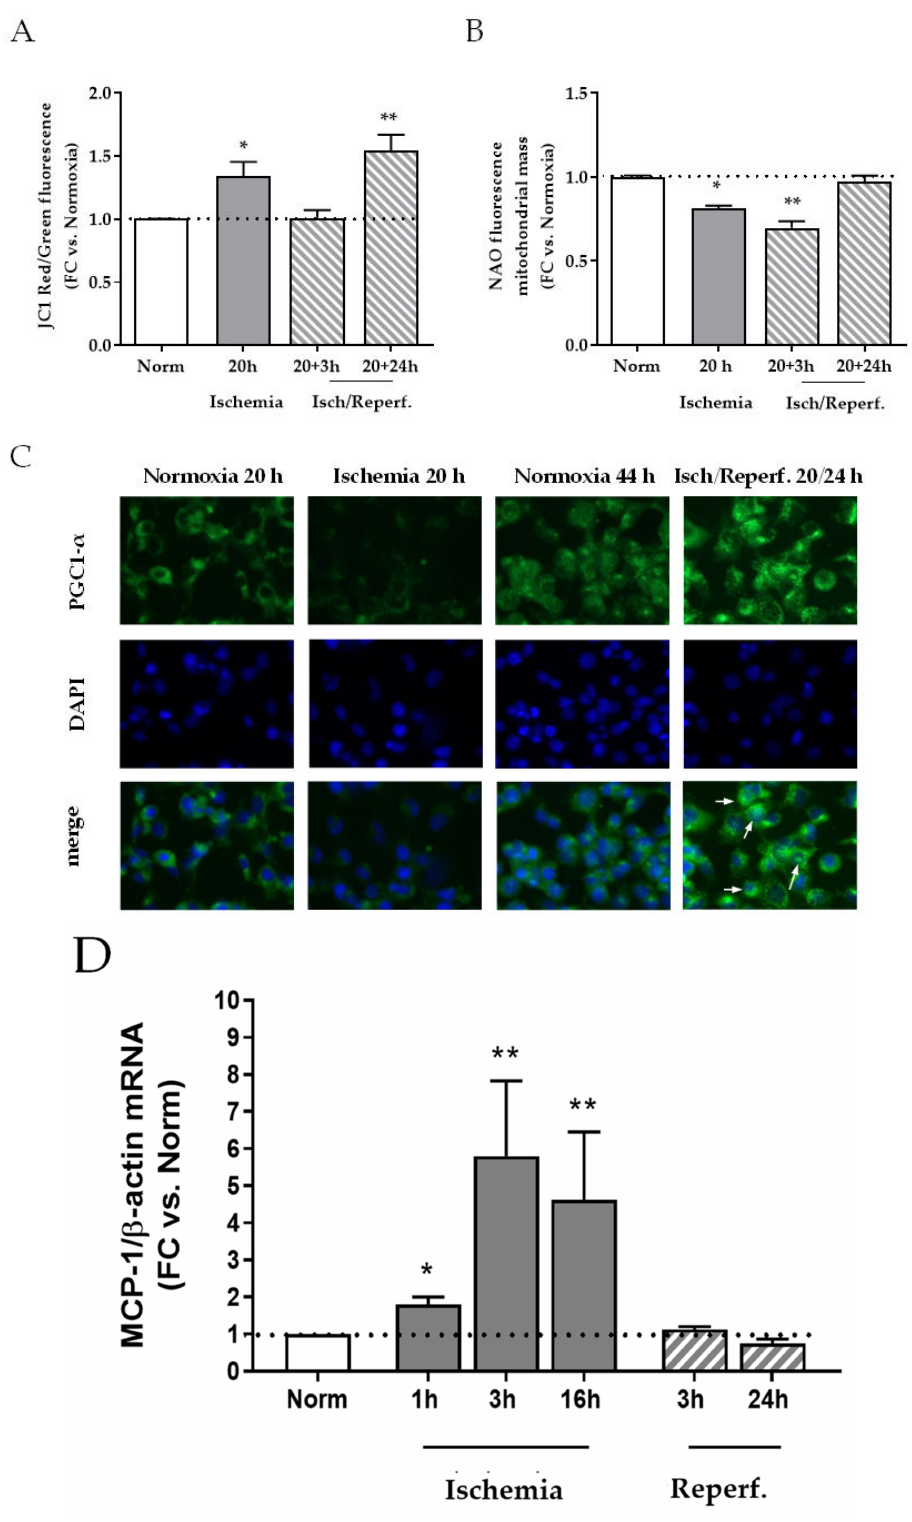
Figure 5. Mitochondrial function during I/R in HK-2 tubular renal cells. ( A ) Mitochondrial membrane potential and ( B ) mitochondrial mass in cells that underwent ischemia and reperfusion, analyzed by flow cytometry with the JC-1 and NAO probes, respectively; values are expressed as fold change (FC) versus normoxia at each time point; * p < 0.05, ** p < 0.01. ( C ) Immunofluorescence for PGC-1 α , green signal (Alexa 488); magnification 20 × . ( D ) MCP-1 mRNA levels after ischemia (1, 3, and 16 h) and reperfusion (3 and 24 h) by quantitative real-time PCR. The results have been normalized by expressing the number of transcript copies as a ratio to β -actin and indicated as fold changes (FC) in comparison to cells maintained in standard conditions for the same time (Normoxia); * p < 0.05, ** p <